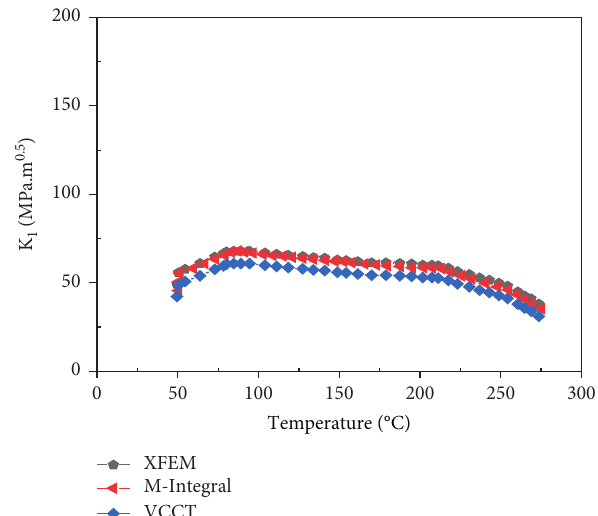
Figure 18: Comparison of K I modeled by M-Integral, XFEM, and VCCT methods at different crack tip temperatures.